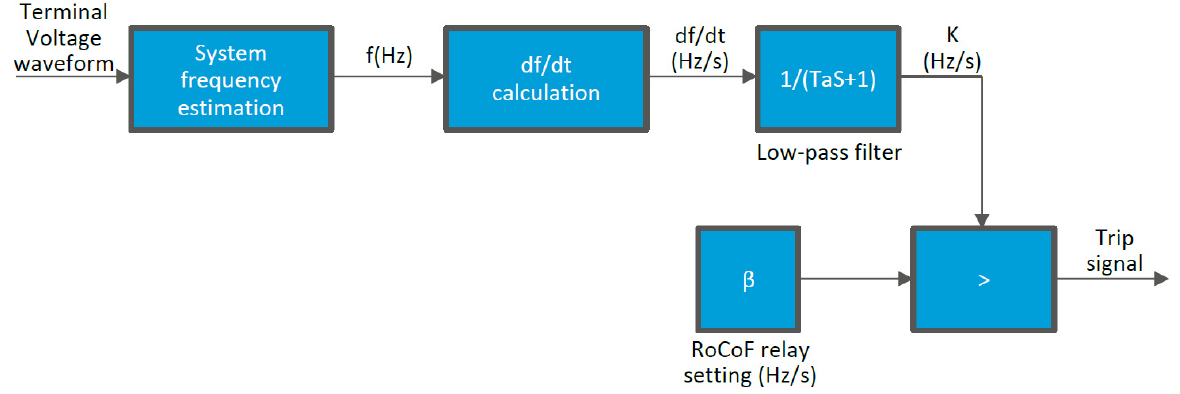
Figure 13. RoCoF schematic diagram.